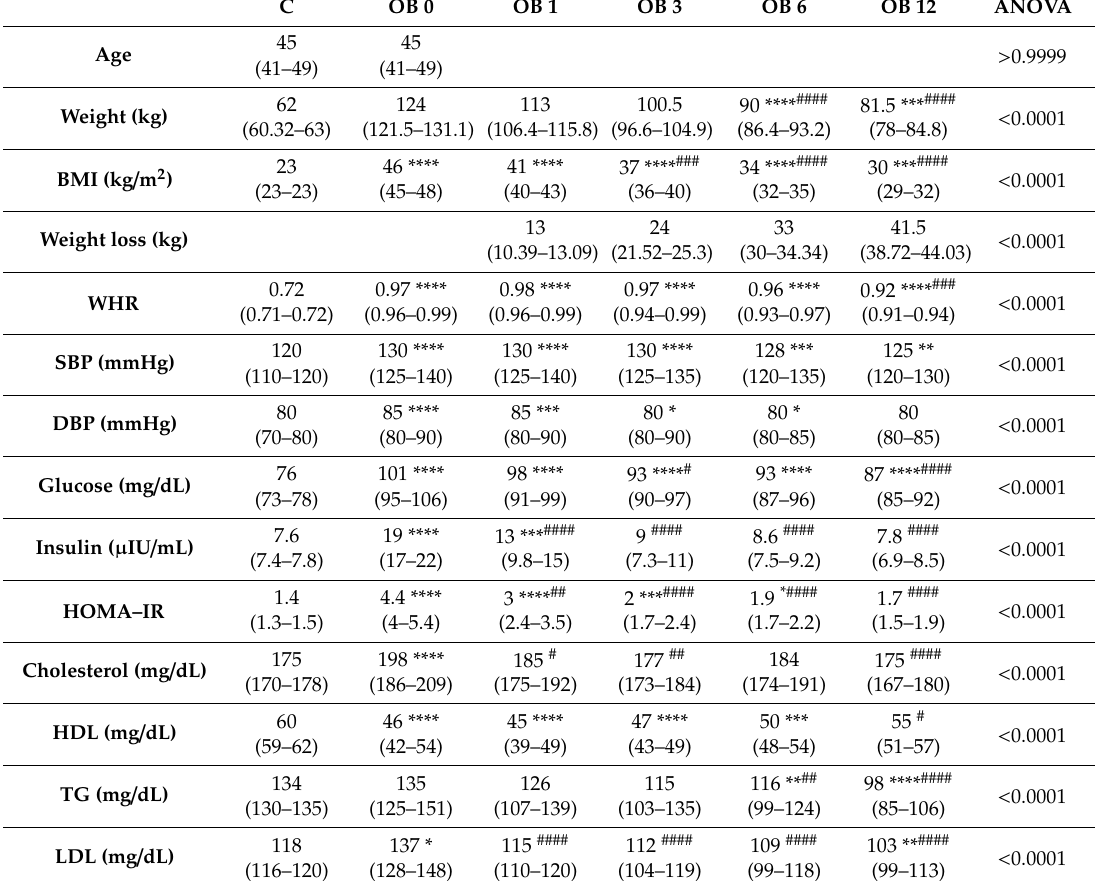
Table 1. Clinical characteristics of the control (C) and morbid obesity (OB). Data given as median (lower and upper confidence limit), * p < 0.05, ** p < 0.01, *** p < 0.001, **** p < 0.0001